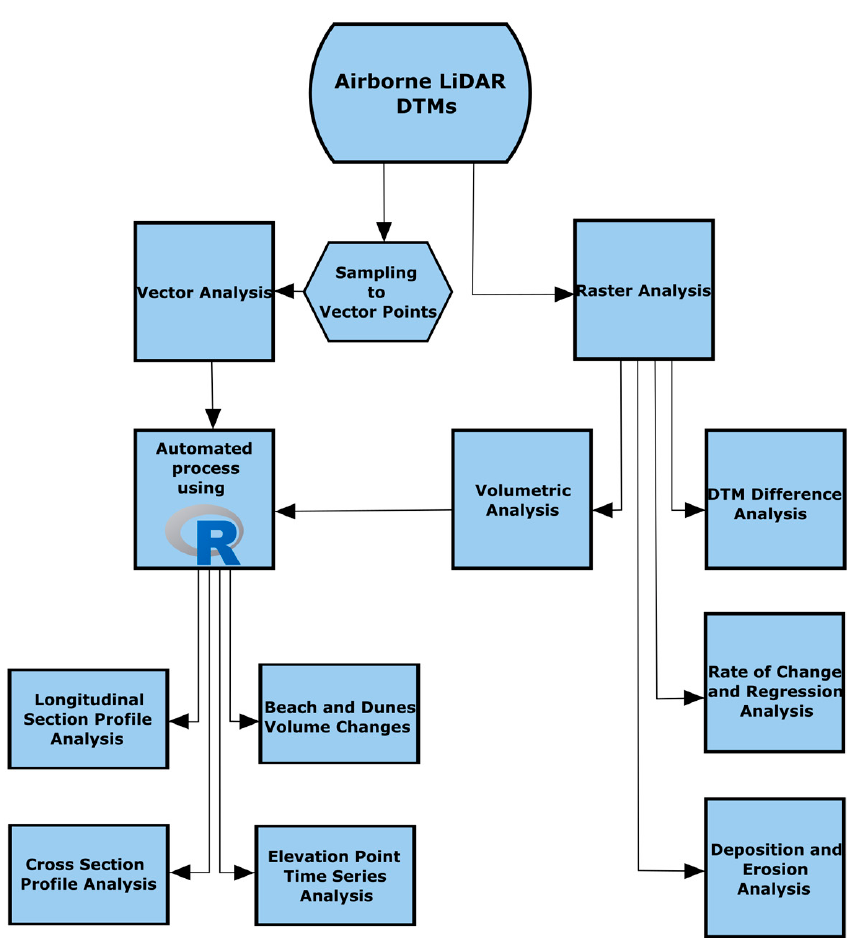
Figure 2. The framework for LiDAR DTM analysis.